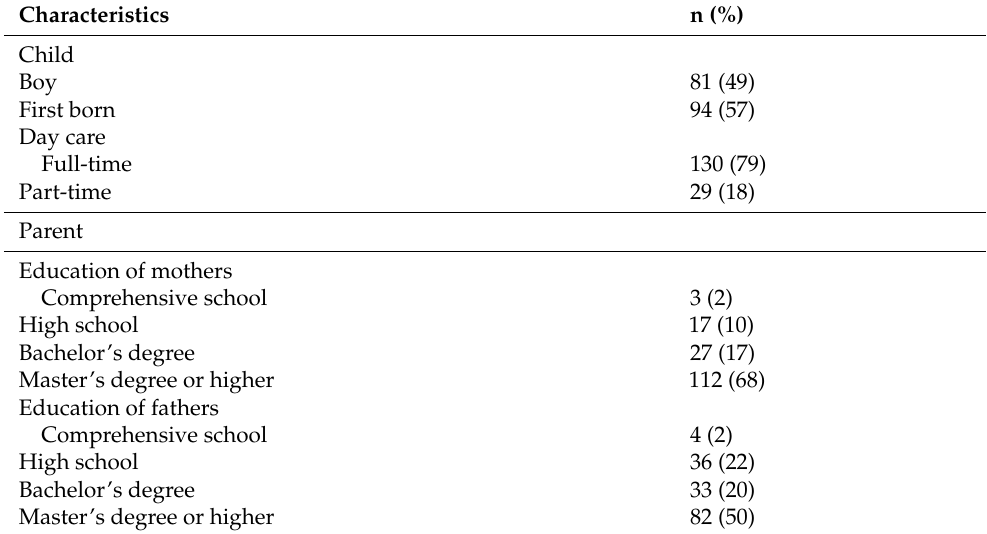
Table 1. Background characteristics of participants (N =